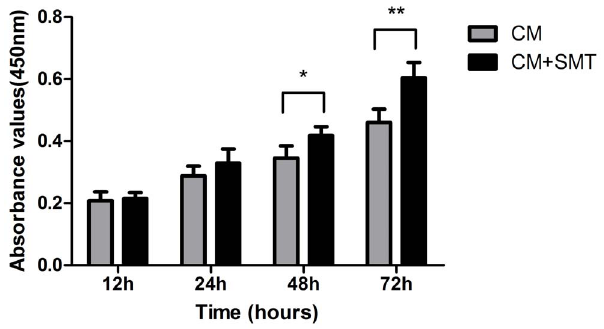
Figure 1. BMSCs inhibit proliferation of microglial cells. To determine whether BMSCs influence the growth of microglia, we used conditioned medium derived from BMSCs to culture microglia with or without LPS. The results show that LPS (1 m g/mL) promotes the proliferation of microglia (LPS groups vs. control groups, **P , 0.01, and ***P , 0.001), while BMSC-CM was effective in inhibiting the prolifera- tion of microglia. The number of cells in the group treated with conditioned medium and LPS (1 m g/mL) decreased significantly compared with cells treated with LPS alone (CM + LPS group vs. LPS group, ### P , 0.001).